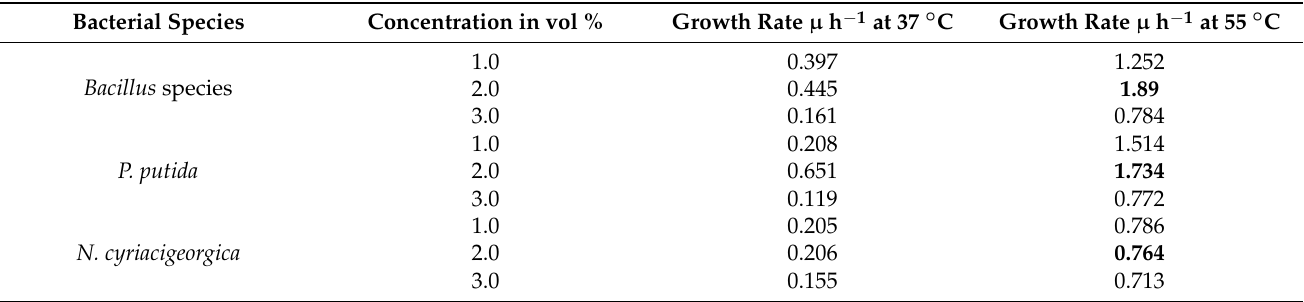
Table 3. Growth rates of the three bacterial strains at different optimum concentrations of Bouri crude oil and different